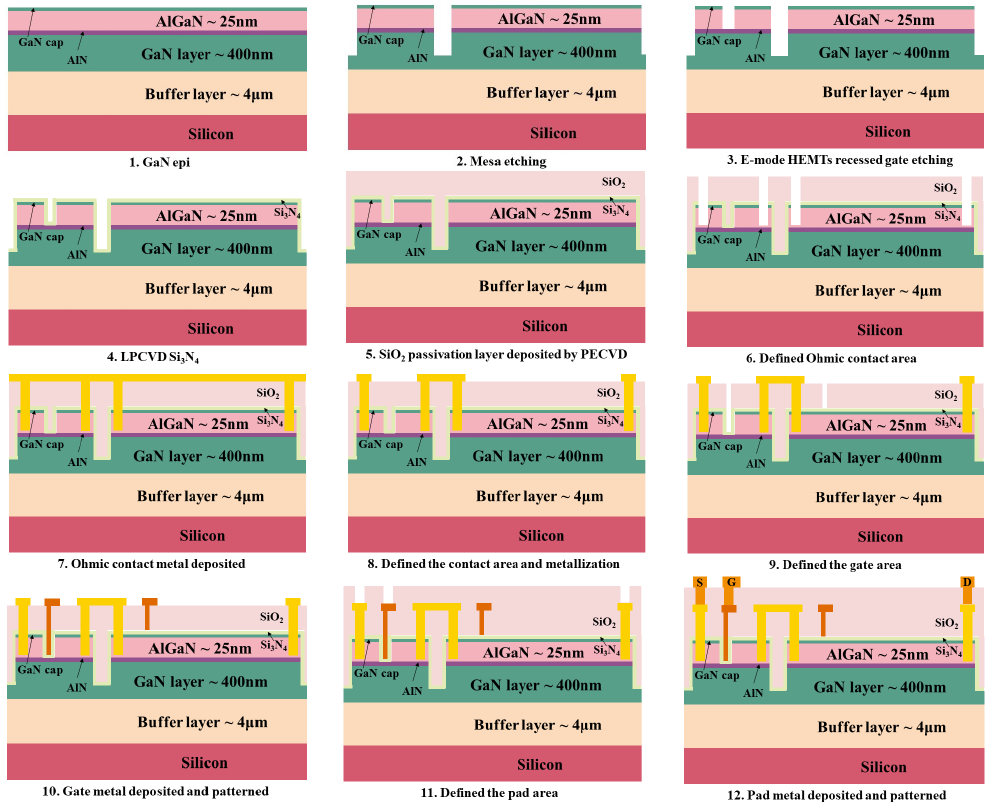
Figure 1. ( 1 – 12 ) Main process steps of the all GaN integrated MIS-HEMT in CMOS fab. Figure 1 shows schematics flow of the all-GaN integrated devices The characterization was performed on the devices with a dimension of L G /L GS /L GD /W= 2/4.5/3/24 µ m for recessed gate MIS-FET and a dimension of L G /L GS /L GD /W = 1/4.5/8/24 µ m for D-mode MIS-HEMT. Figure 2 shows the schematic view and cross-section TEM image of the fabricated all-GaN integrated